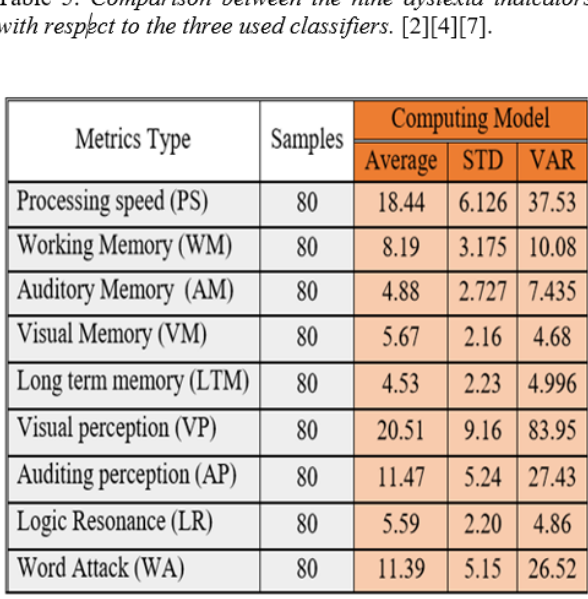
Table 2. Comparison of K means, ANN, Fuzzy logic